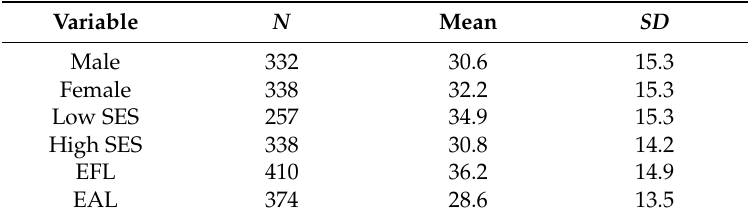
Table 2. Descriptive statistics for the three variables of this study. Reading comprehension scores of gender, SES and language groups.